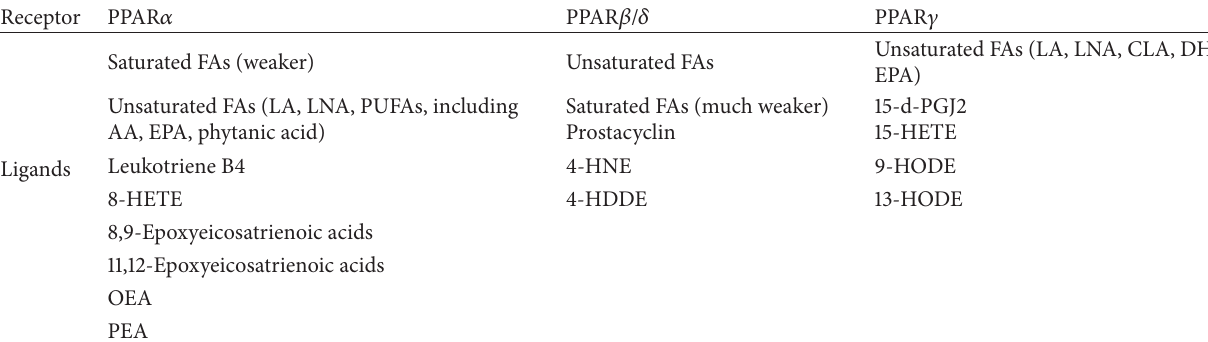
Table 2: FAs and their derivatives as PPARs